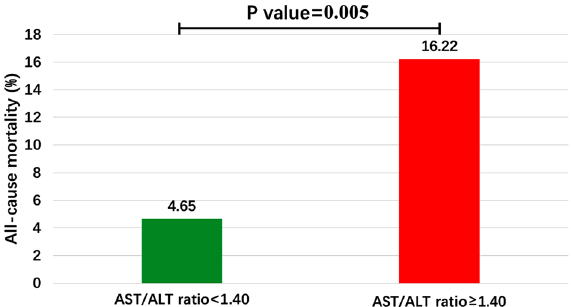
Figure 3. Comparison of all-cause mortality between low group (AST/ALT ratio < 1.40) and high group (AST/ ALT ratio ≥